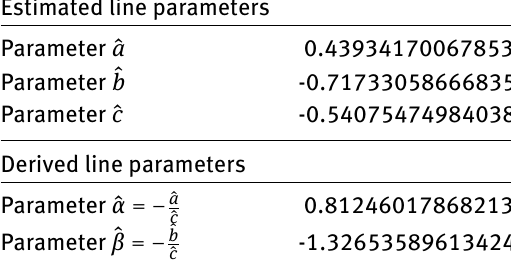
Table 7: Direct LS solution - line fit 3D